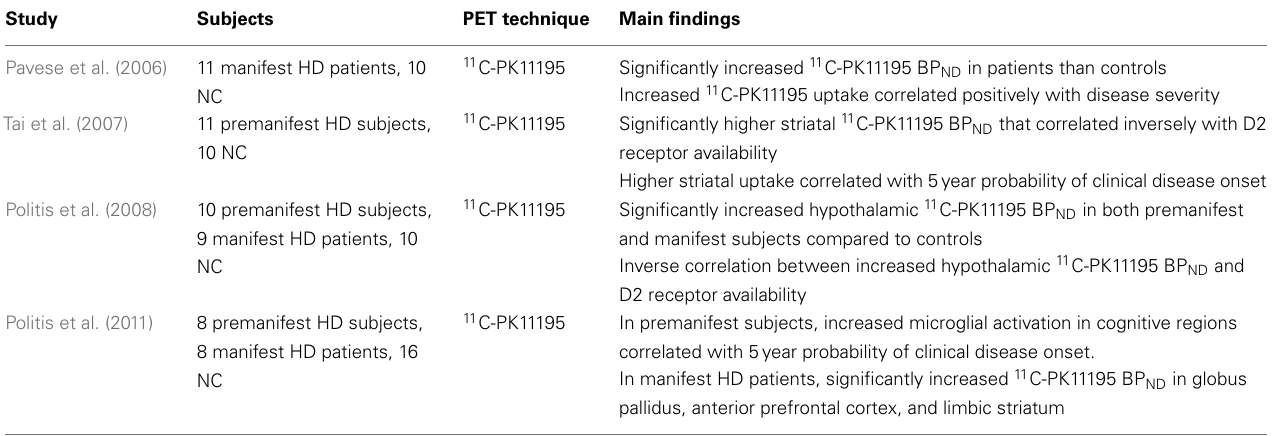
Table 2 | Positron emission tomography imaging studies assessing microglia in Huntington’s